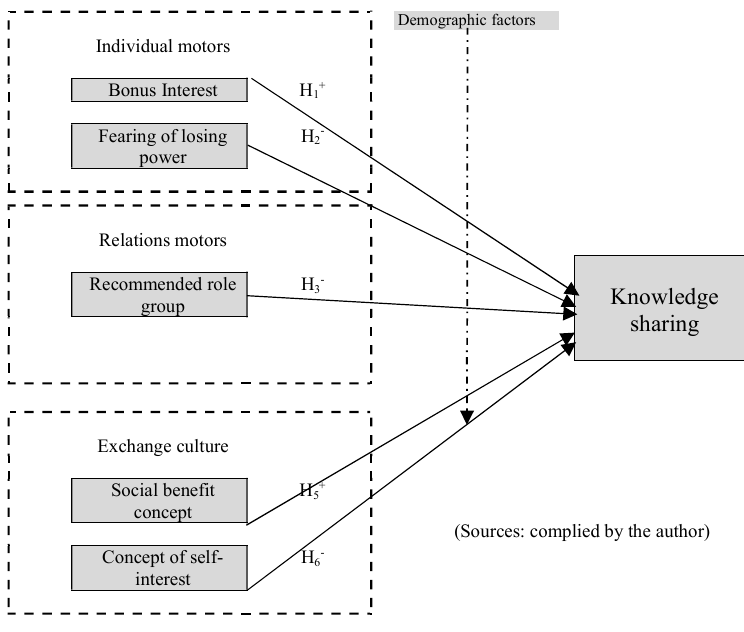
Fig. 3. The modified model